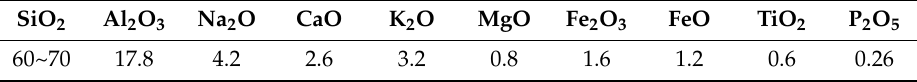
Table 3. The chemical composition of natural zeolite